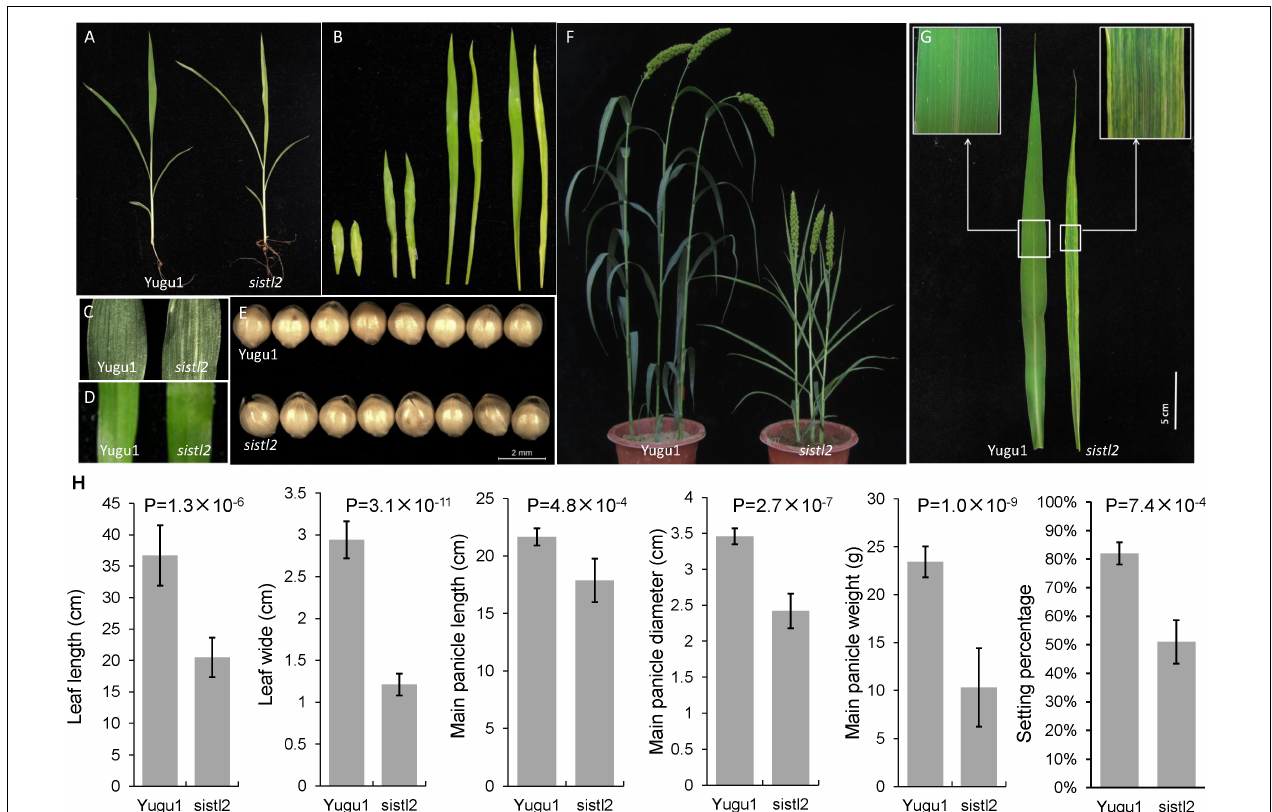
FIGURE 1 | Phenotypic characterization of sistl2 mutant. (A) The four-leaf stage seedlings of Yugu1 and sistl2. (B) The first four leaves of Yugu1 and sistl2 were placed in order from left to right. In each couple, the left one is Yugu1, and the right one is sistl2 . (C) The first leaf of Yugu1 and the mutant. (D) The third leaf of Yugu1 and the mutant. (E) The seeds of Yugu1 and sistl2 . (F) Heading stage phenotypes of Yugu1 and sistl2. (G) The mature leaves of Yugu1 and sistl2 of heading stage. (H) The leaf length and leaf width were clearly reduced in addition to the panicle size, panicle weight, and the seed setting percentage of Yugu1 and sistl2. The leaves used for size measurement are mature top second leaves of Yugu1 and sistl2 at heading stage, respectively. The means and standard deviations were obtained from five independent leaf samples. Statistical analysis was performed with the t